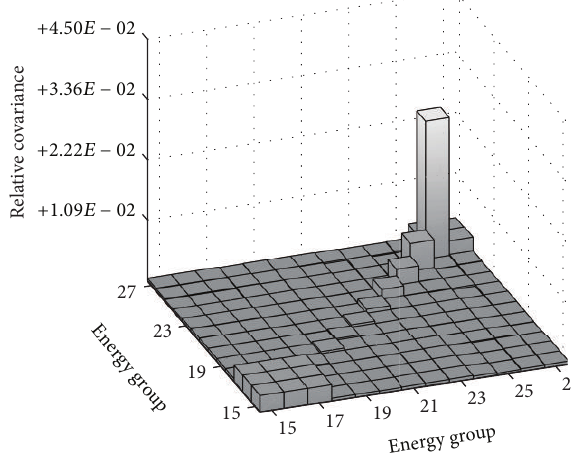
Figure 17: 𝜎 U 235 𝛾 covariance at 𝜎 0 = 800𝑏 .